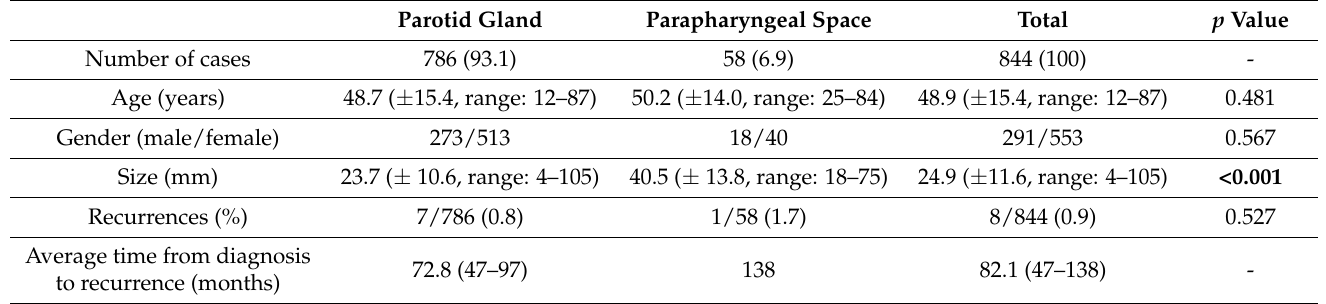
Table 1. Comparative analysis of the demographic and clinical parameters in pleomorphic adenomas of the parotid gland and parapharyngeal space in our study ( p values in bold: statistically significant). Parotid Gland Parapharyngeal Space Total p